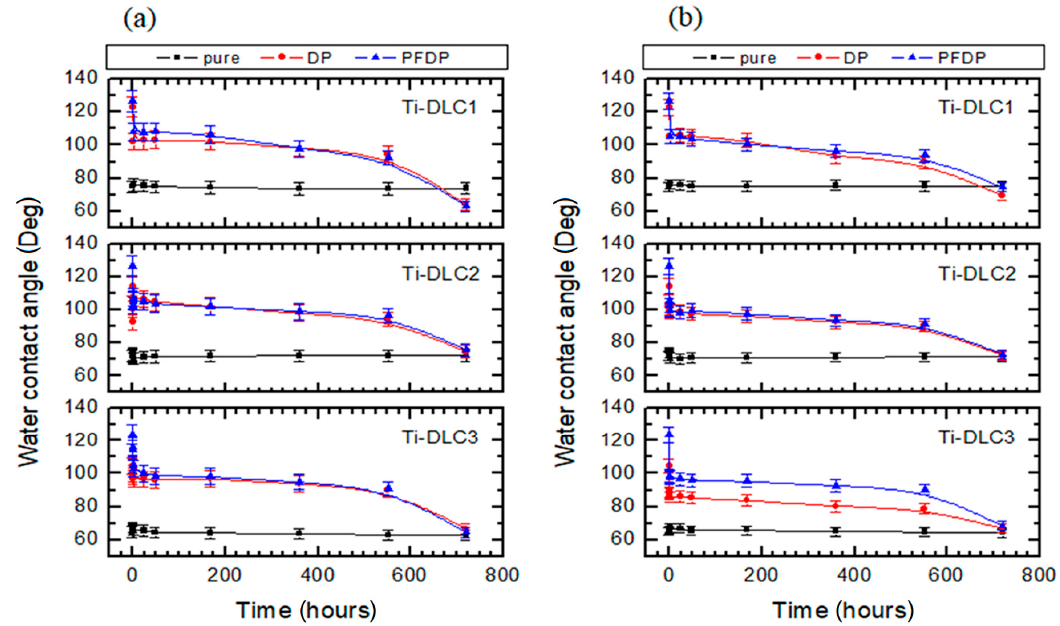
Figure 4. Stability of the water contact angle modified by DP and PFDP Ti-DLC after immersion in ( a ) PBS and ( b ) TBS solutions.